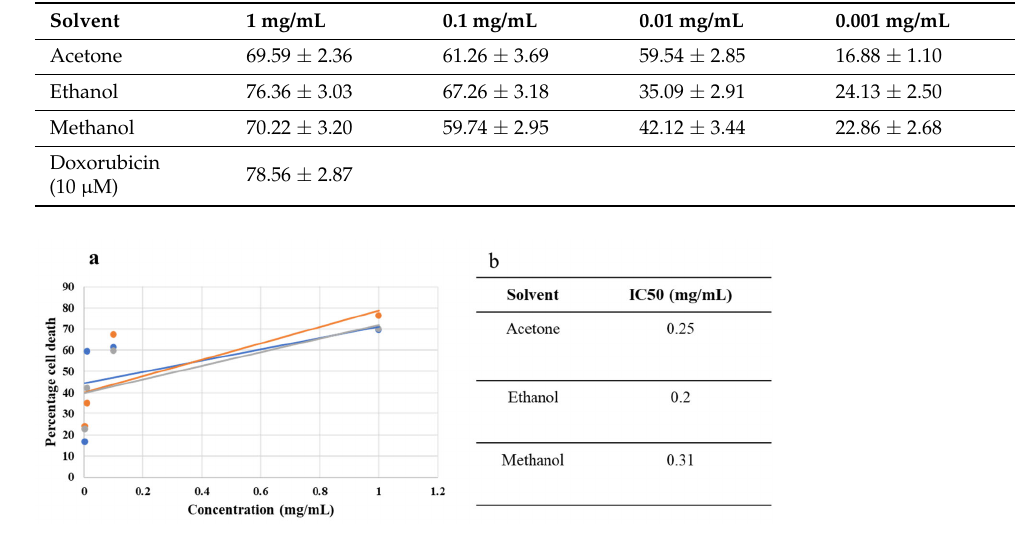
Figure 3. Dose–response curve ( a ) and IC 50 values ( b ) of acetone-, ethanol-, and methanol-based extracts.